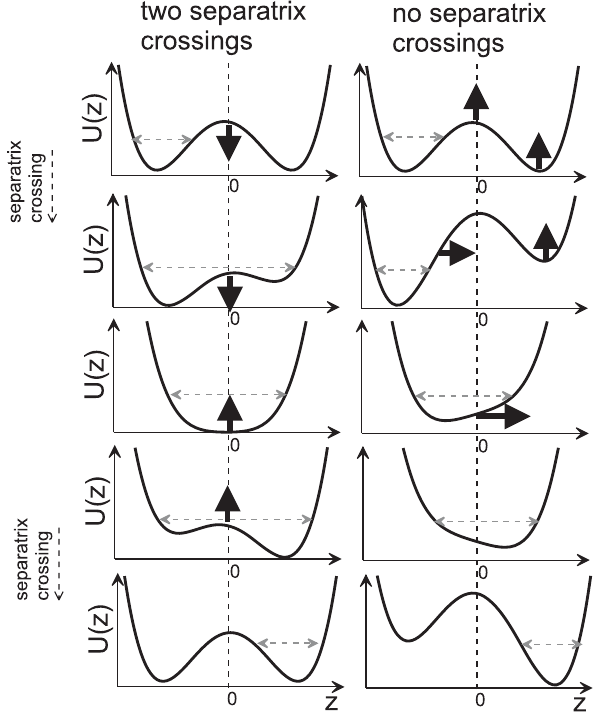
Fig. 6. Left column shows successive profiles of U(z) and particle positions (from top to bottom) for transition from left well to right well with two separatrix crossings. Right column shows the same transition, but without separatrix crossings. Grey arrows correspond to particle position U = 1 / 2 and black arrows show direction of U(z)